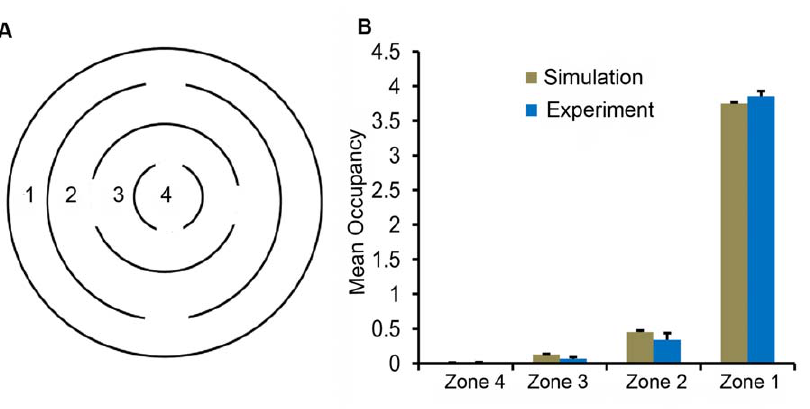
Figure 5. Vertical and horizontal transitions inside an hourglass-shaped arena. A. The hourglass-shaped arena is shown. A fly walking in this arena may make a horizontal transition (H.T) by following the wall from one chamber to the next, or it may make a vertical transition (V.T) by crossing the central gap. B . The vertical transition indices, both from simulations and experiments, are shown. There was no significant difference between the experiments and simulations. Drosophila showed more horizontal transitions.